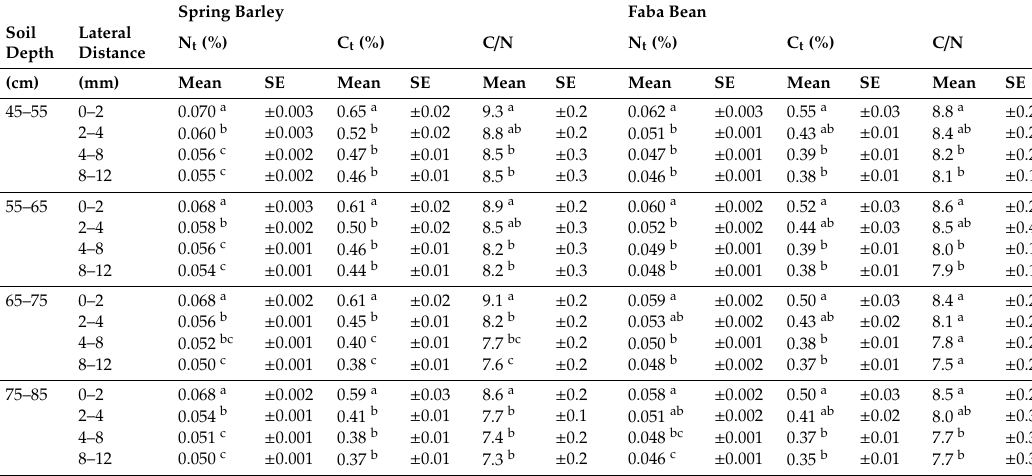
Table 3. Lateral variations of N t -, C t -content and CN-ratio from biopore lumen to 8–12 mm. Mean and SE of the distances from macropore in di ff erent depth intervals. Means not sharing a common letter indicate significant di ff erences between the distances from macropore within one depth interval (Tukey HSD, α =